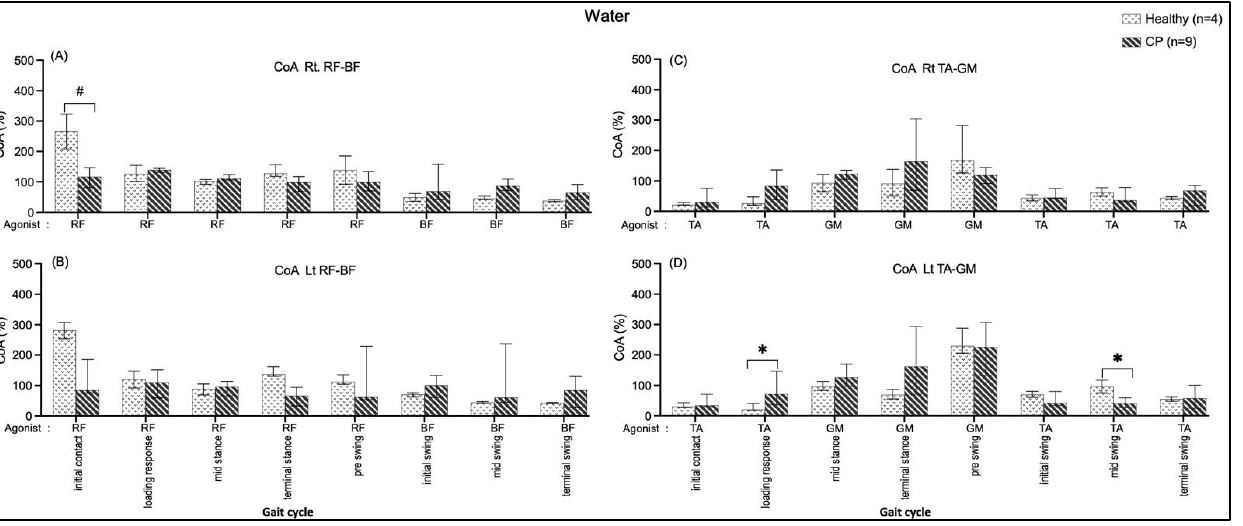
Figure 9. Co-activation index (CoA) of right RF-BF ( A ), left RF-BF ( B ), right TA-GM ( C ), and left TA-GM ( D ) during walking in water in healthy and CP. * and # are significant median differences between walking on land and in water at p < 0.05 and p < 0.01.